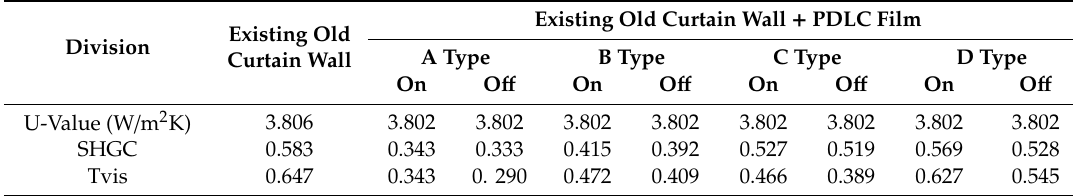
Table 6. Optical and thermal properties of curtain wall system with a PDLC film Existing Old Division